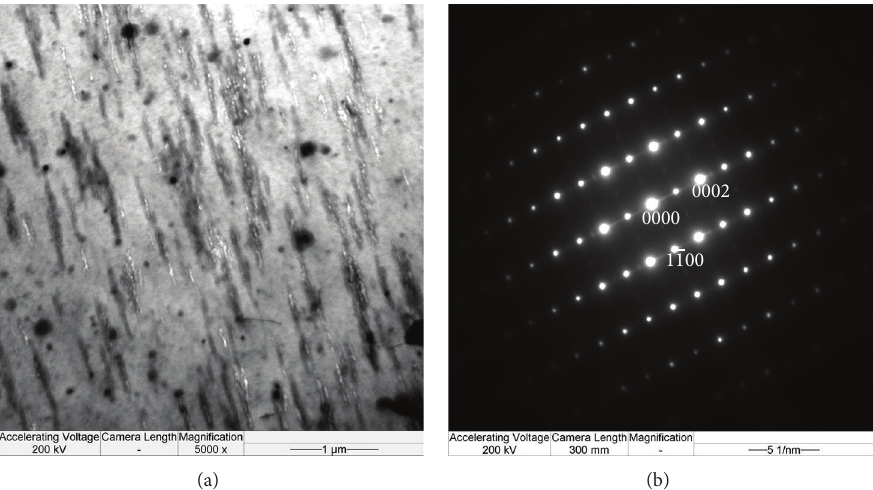
Figure 1: TEM image and electron diffraction pattern aged at 200 ∘ C for 8h along [1120] 𝛼 zone axis: (a) TEM image; (b) electron diffraction pattern.